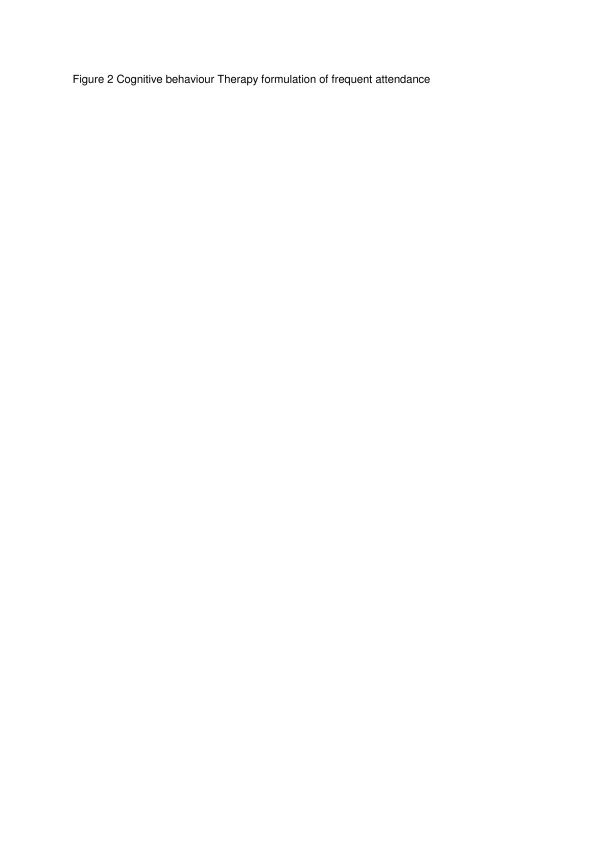
Cognitive behaviour Therapy formulation of frequent attendance.